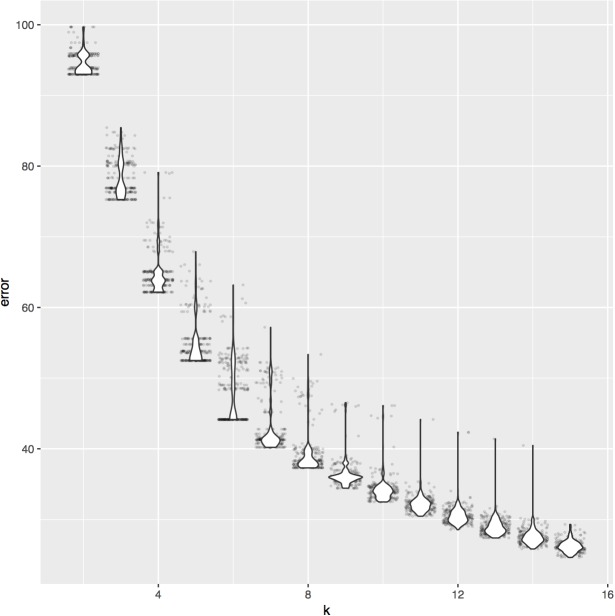
K-means clustering results (250 iterations) of the Deep Learning distance metric of 74 metagenomes based on the coordinates and identity of 738,324 SAAVs.The elbow of this curve is k = 6, which informed our decision to define six proteotypes.